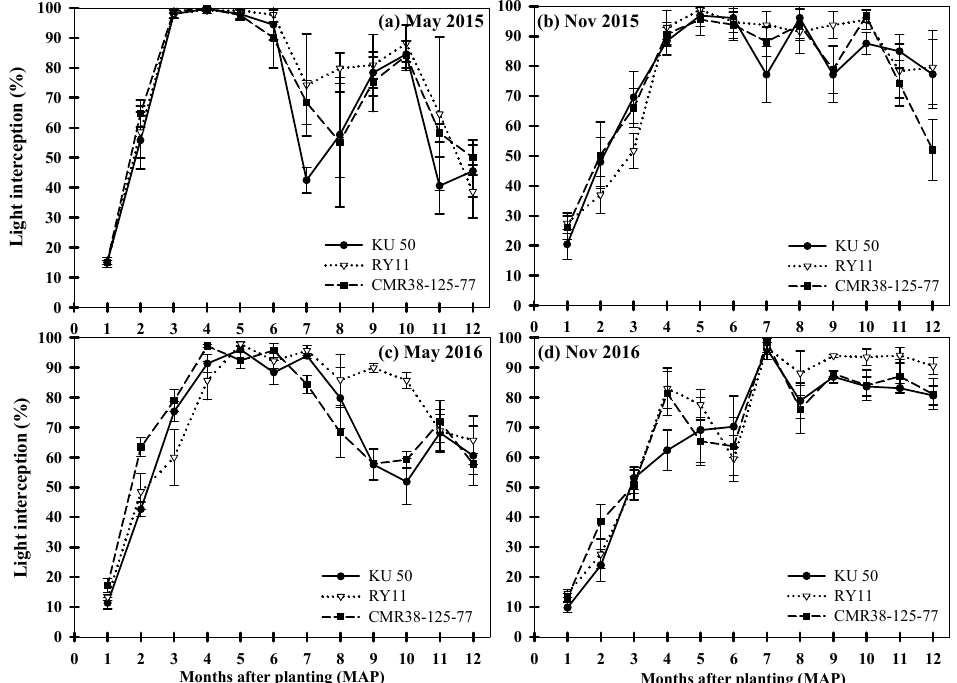
Figure 2. Light interception percentage of 3 cassava genotypes planted in May and November 2015 ( a , b ) and 2016 ( c , d ).